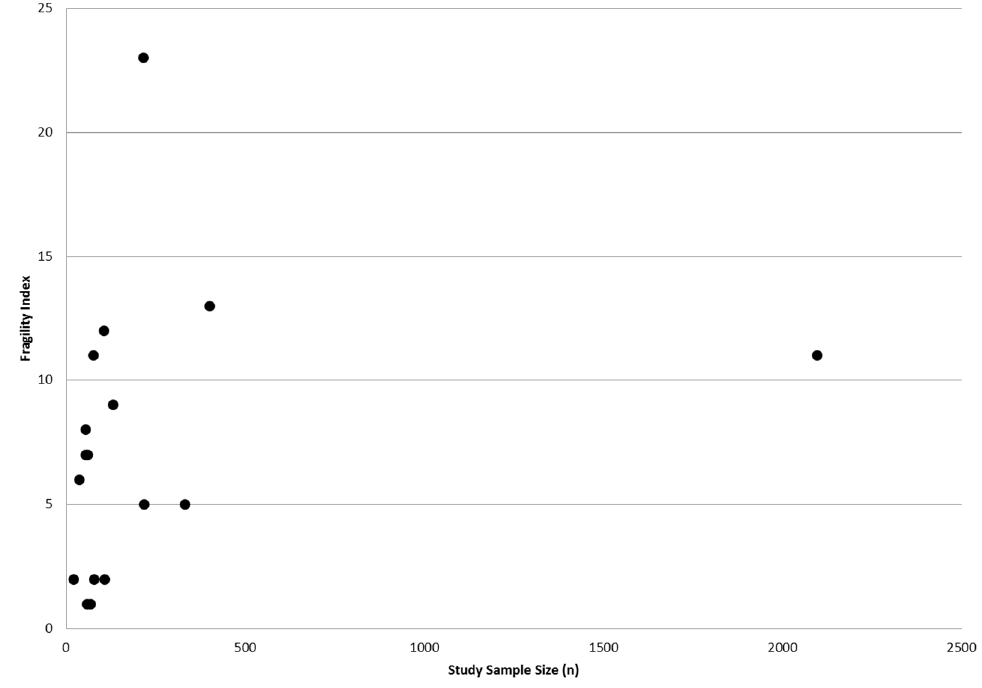
Figure 1. Correlation between RCT sample size and calculated Fragility Index ( r = 0.249, p = 0.335).